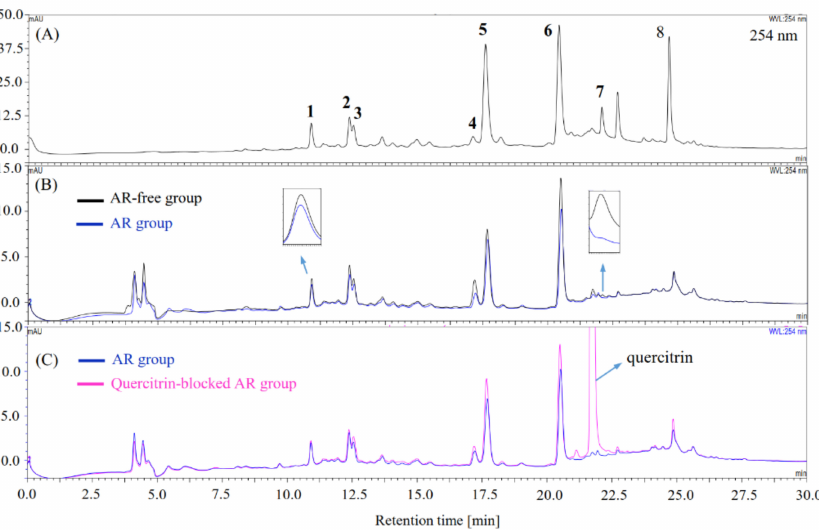
Figure 2. Chromatogram of ultrafiltration-HPLC for screening aldose reductase (AR) inhibitors from the 70% MeOH extract of V. rigida root. ( A ) HPLC chromatography (254 nm) of the 70% MeOH extract of V. rigida root; ( B ) chromatograms of the centrifugal filtrates of AR-free group (black line) and AR group (blue line); ( C ) chromatograms of the centrifugal filtrates of AR group (blue line) and quercitrin-blocked AR group (red line). Compounds 1 – 7 were screened as AR